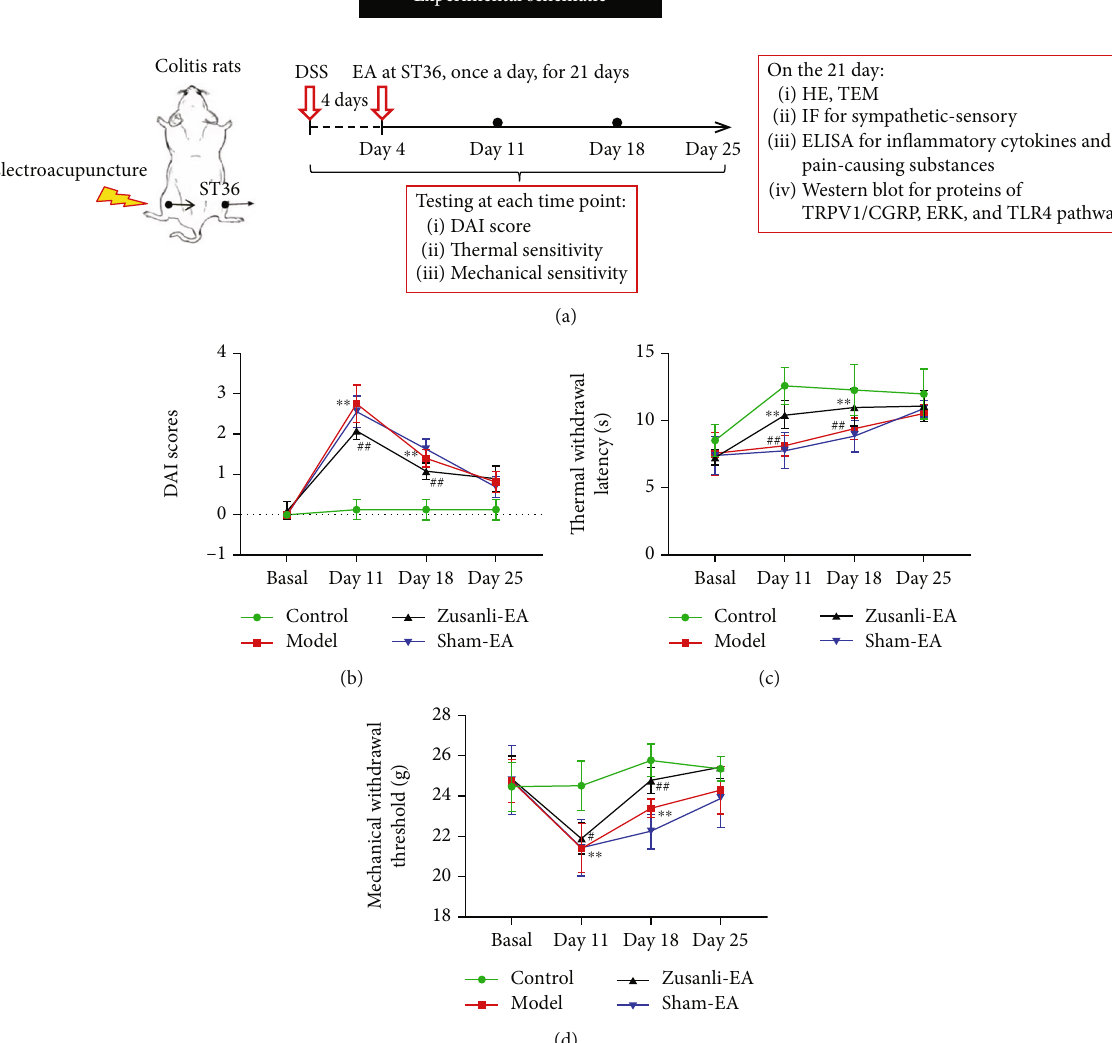
Figure 1: EA attenuated colitis severity and somatic hyperalgesia in DSS-induced colitis rats. (a) Schematic describing experimental design. The rats were gavaged with dextran sulfate sodium (DSS) saline solution for 4 days to establish a colitis rat model. Then, the rats in the Zusanli electroacupuncture (Zusanli-EA) group were treated with EA, once a day, for 21 consecutive days. (b – d) Disease activity index (DAI), thermal withdrawal latency (TWL), and mechanical withdrawal threshold (MWT) were measured at 7 days, 14 days, and 21 days in DSS-induced colitis rats. DAI = ð weightlossratescore + stoolconsistency score + presence of blood in stoolsscore Þ /3 . ∗∗ P < 0 : 01 vs. control group, # P < 0 : 05 vs. sham-EA group, ## P < 0 : 01 vs. sham-EA group. Data represents means ± SD